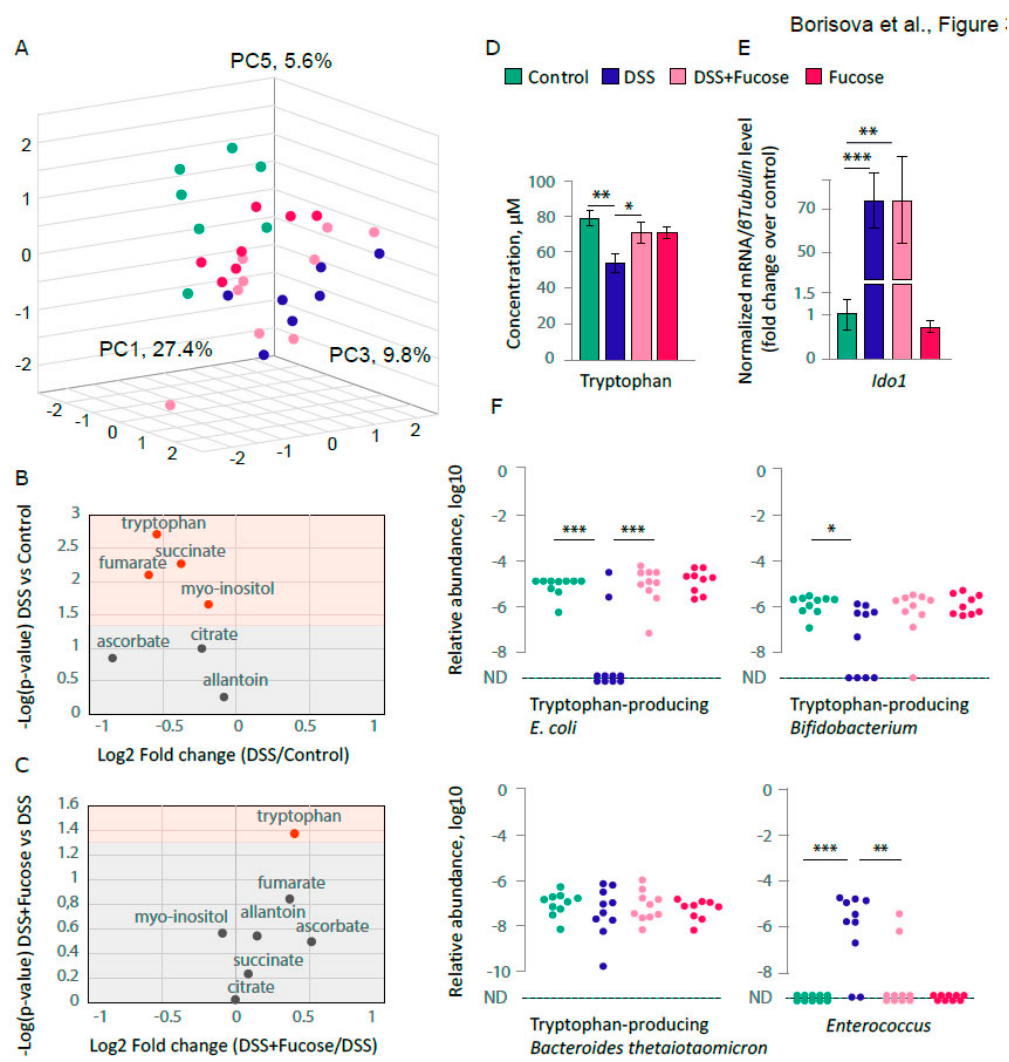
Figure 3. Fucose normalizes the levels of blood tryptophan and tryptophan-producing bacteria. ( A ) Metabolite concentrations in blood serum of test animals measured by NMR and analyzed using PCA plotted for PC1, PC3, and PC5. ( B ) Blood serum metabolite concentrations, “Control” vs. “DSS”, Student’s t- test for independent samples. Significant values ( p < 0.05) are shown in red. ( C ) Blood serum metabolite concentrations, “DSS” vs. “DSS + Fucose”, Student’s t- test for independent samples. Significant values ( p < 0.05) are shown in red. ( D ) Blood serum tryptophan concentration measured by NMR. * = p < 0.05, ** = p < 0.01, Student’s t- test for independent samples. ( E ) Expression of the Ido1 gene in the descending colon normalized on the β Tubulin ( Tubb5 ) gene. ** = p < 0.01, *** = p < 0.001, Student’s t- test for independent samples. ( F ) Abundance of the intestinal bacteria measured in feces by real-time PCR normalized on the universal region of the 16S rRNA gene, ND—not detected (* = p < 0.05, ** = p < 0.01, *** = p < 0.001, χ 2 test).